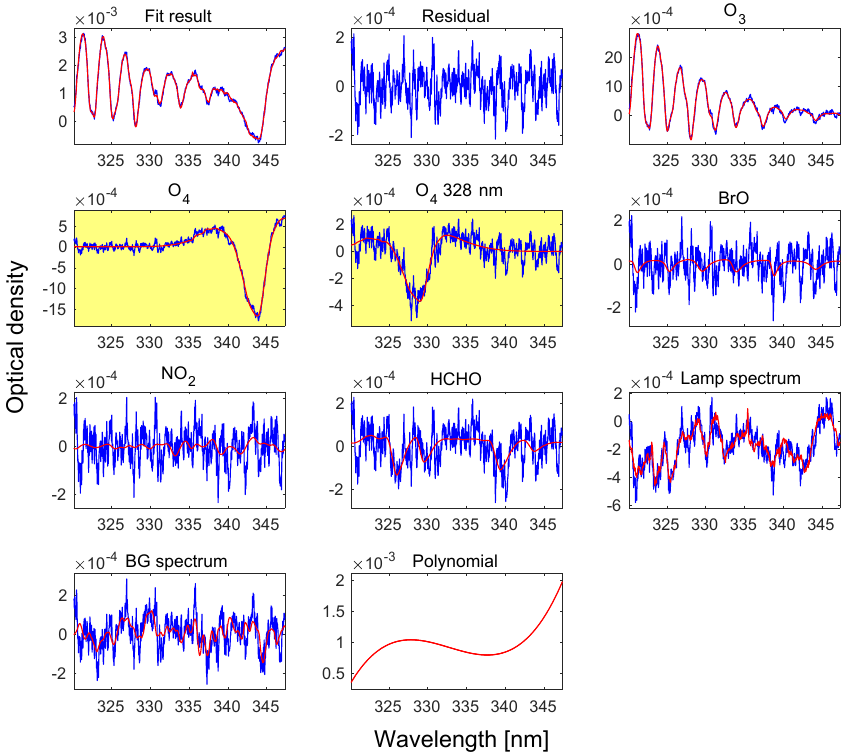
Figure 2. Exemplary LP-DOAS fit result of a measurement from 22 November 2012 on the 8km light path. The O 4 absorption at 328nm is clearly visible. The retrieved column densities are O 4 ( 2 . 67